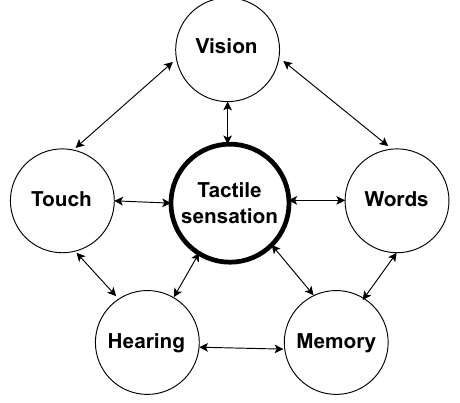
Figure 5. Parameters for extracting tactile sensations